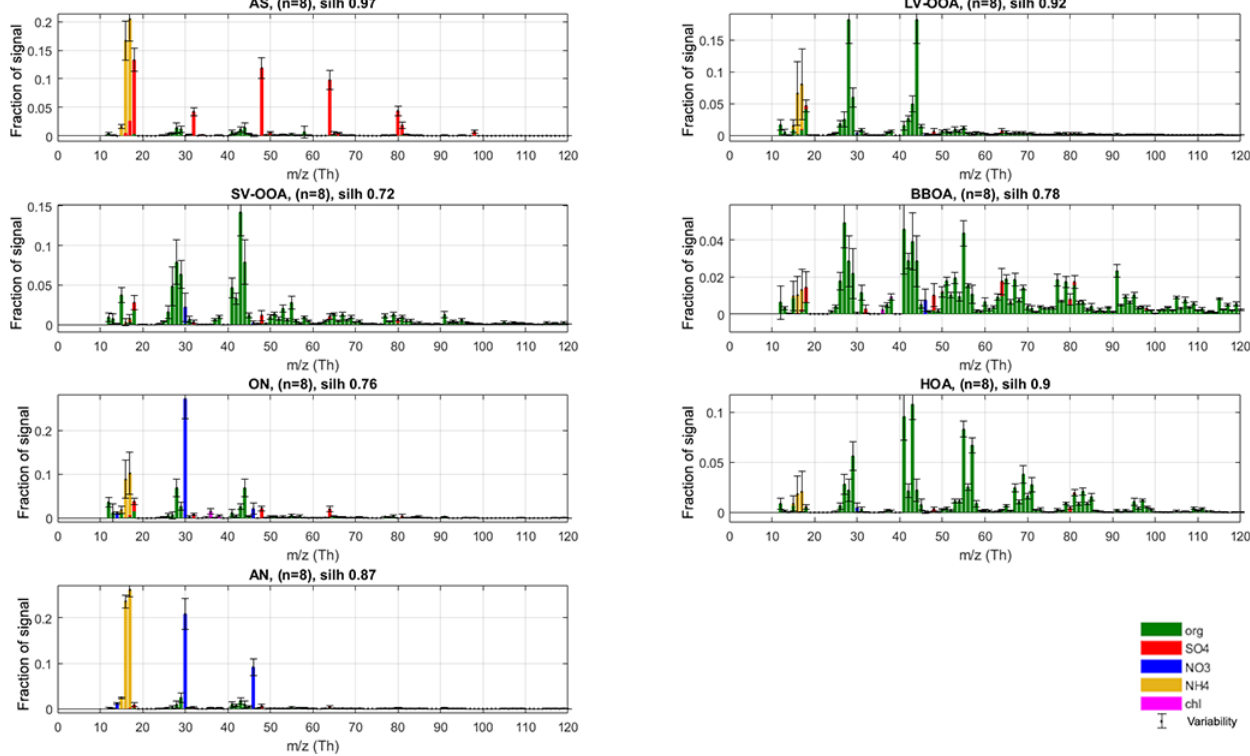
Figure 4. Final silhouette-weighted reference spectra (coloured bars) and variabilities (error bars) for the r-CMB model